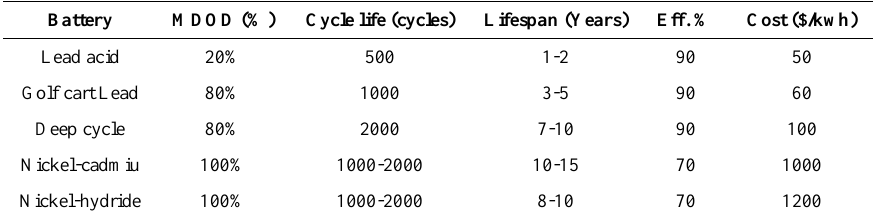
Table 3. Types of Batteries and their